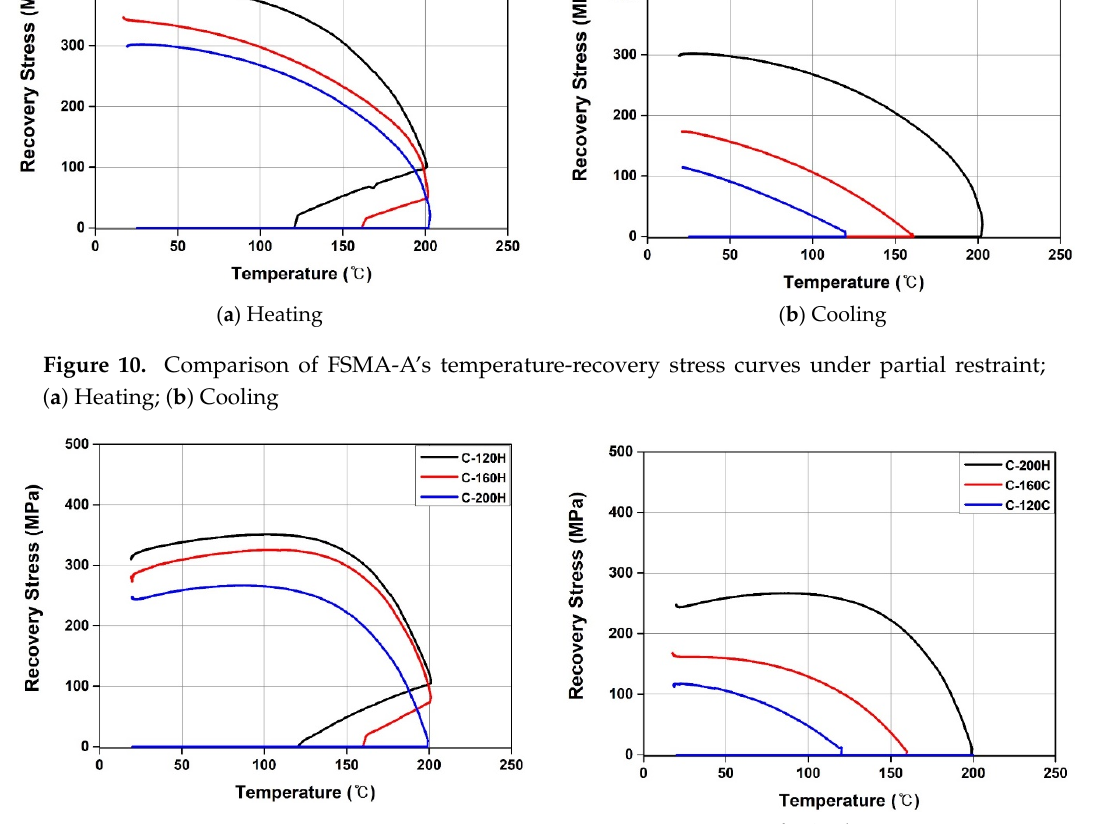
Figure 11. Comparison of FSMA ‐ C’s temperature ‐ recovery stress curves under partial restraint; ( a )